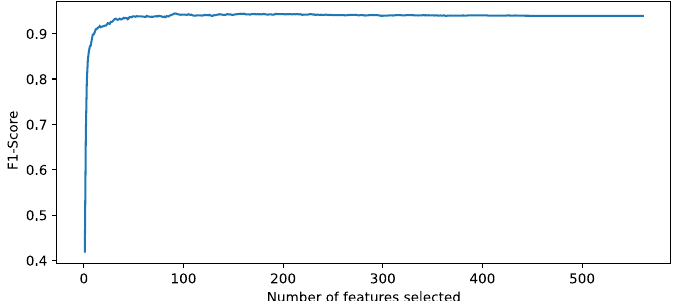
Figure 3. Performance of baseline SVC for number of selected features using RFECV with Stratified- KFold cross validation.